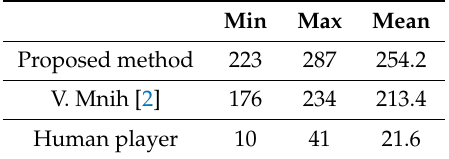
Table 5. Testing results of the Flappy Bird game using various